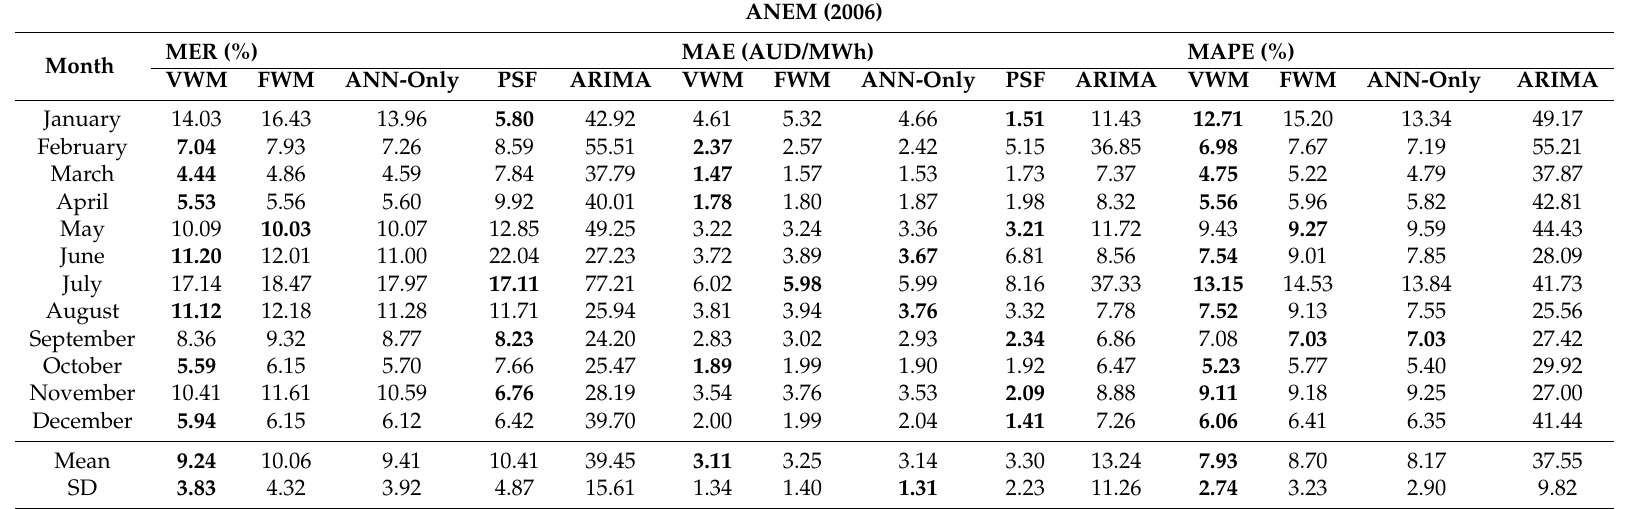
Table 3. MER, MAE and MAPE evaluation metrics for the ANEM (Australian Energy Market Operator) market for the year 2006 (Experiment